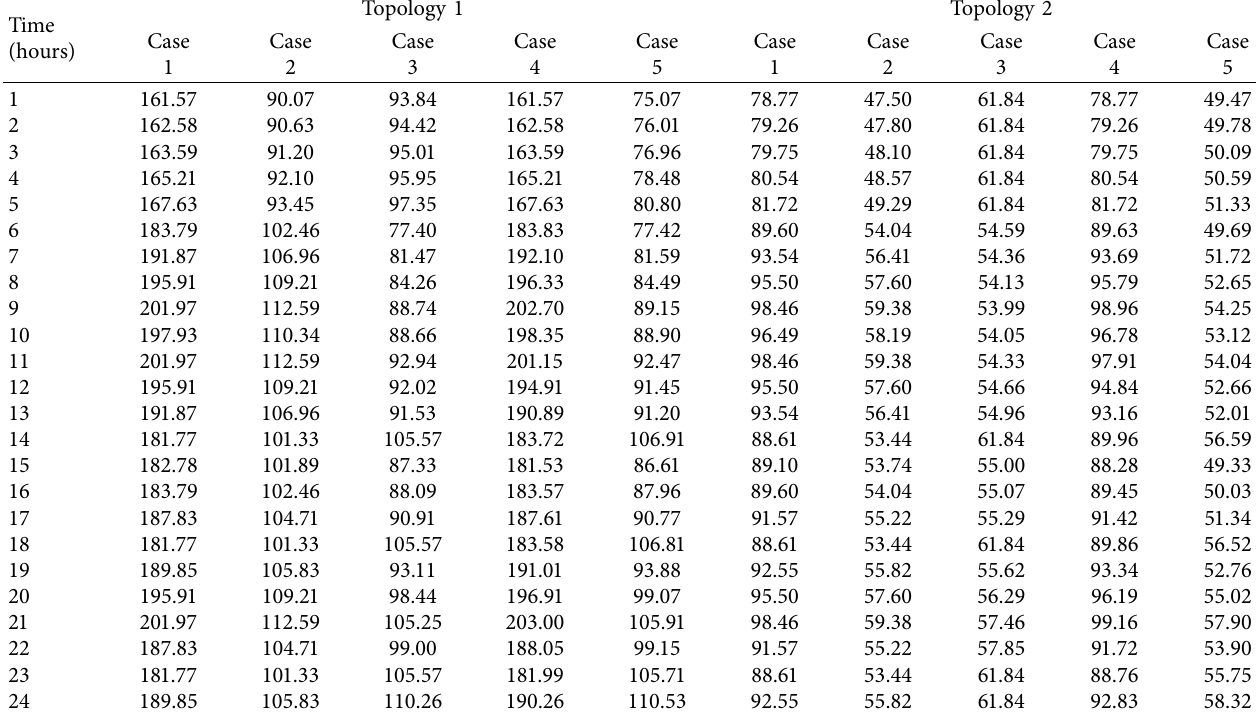
Table 6: Power loss (in kW) 33 bus system scenario 1.